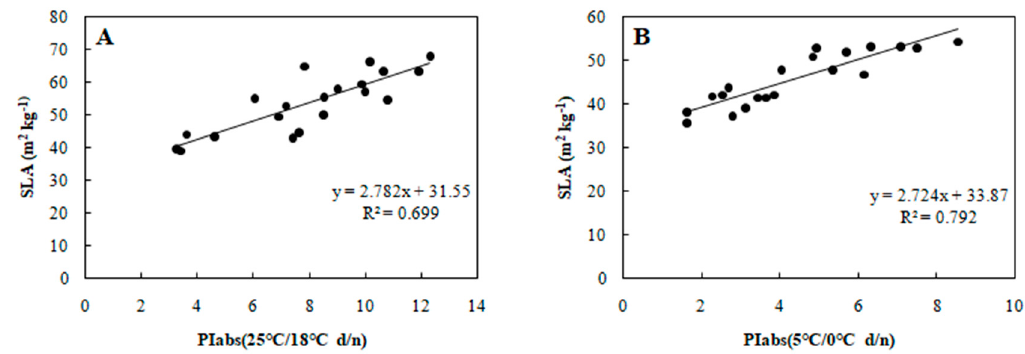
Figure 4. Correlation between PIabs and SLA in 20 wucai genotypes measured in ( A ) 25/18 °C (d/n) treatment and ( B ) 5/0 °C (d/n) treatment.